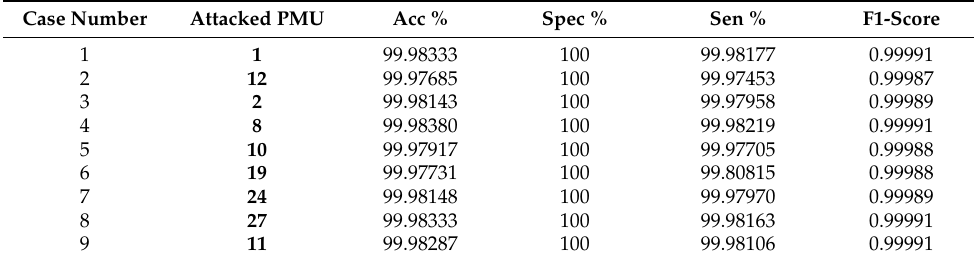
Table 4. Scenario III: Sample results for the IEEE-30 bus system.